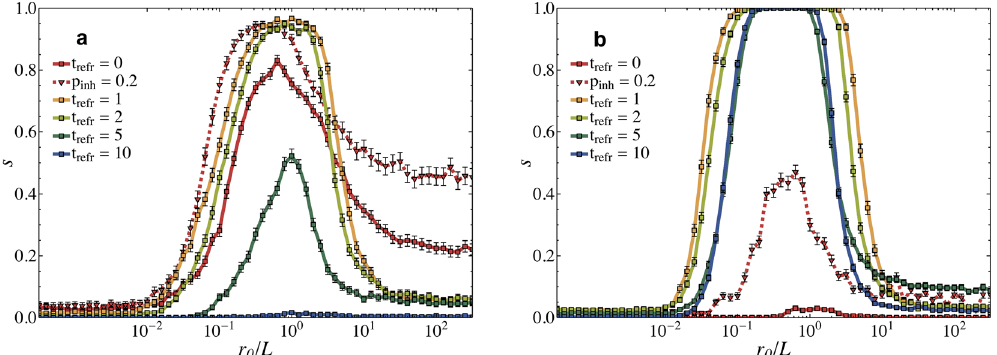
Figure 5. Role of the refractory time on the performance. ( a ) The success rate s for different refractory times, ranging from t performed simulations with inhibitory neurons p inh = 0.2 resulting in an overall performance improvement. The error bars represent a 95% confidence